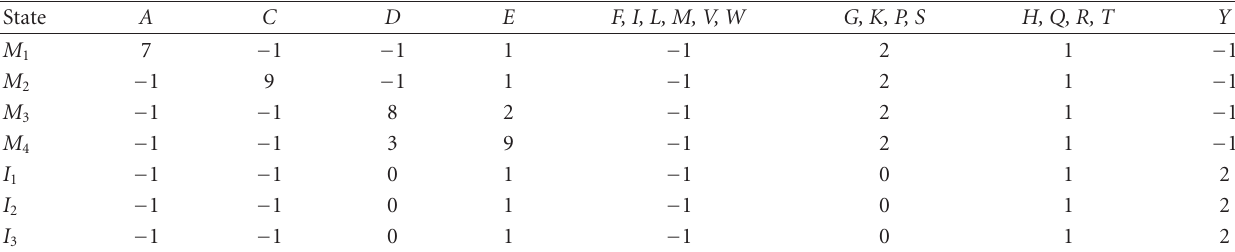
Table 1: Emission scores of amino acids for match and insert states of profile HMM of Figure 2.